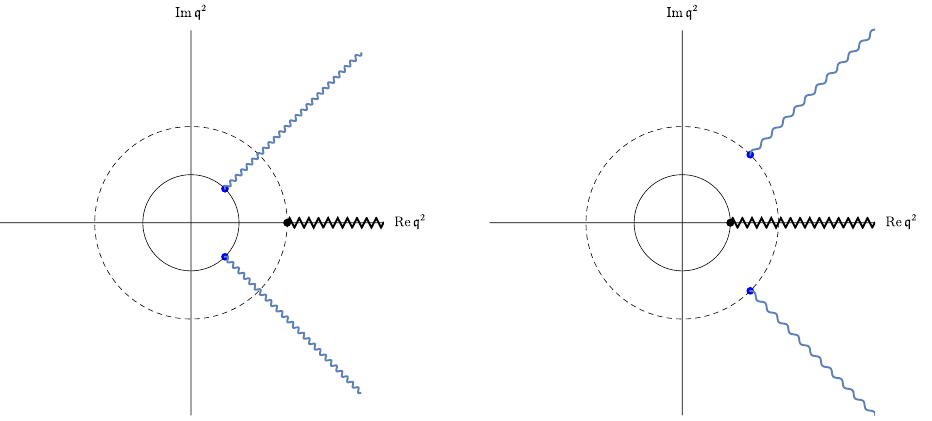
Figure 6 . The closest to the origin branch points of the shear mode dispersion relation w = w ( q 2 ) in the complex q 2 -plane (shown schematically). The radius of convergence is determined by the pair of branch points (left panel) or the branch point on the real axis (right